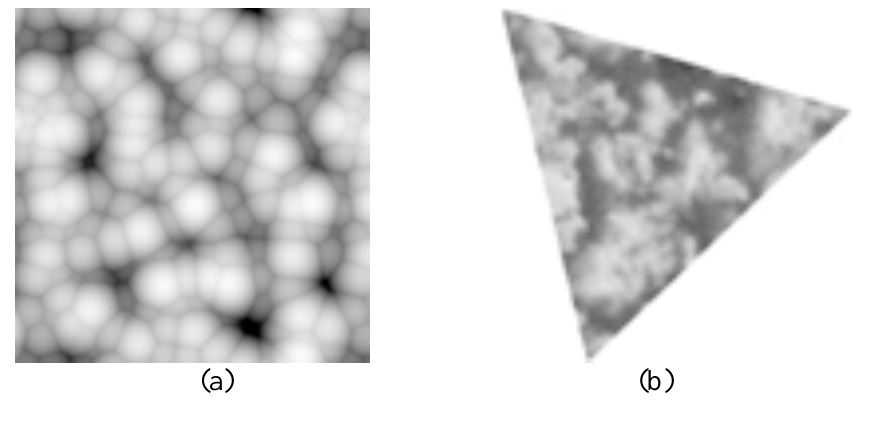
Figure 5. Shapes used for testing. (a) A rectangle. (b) A